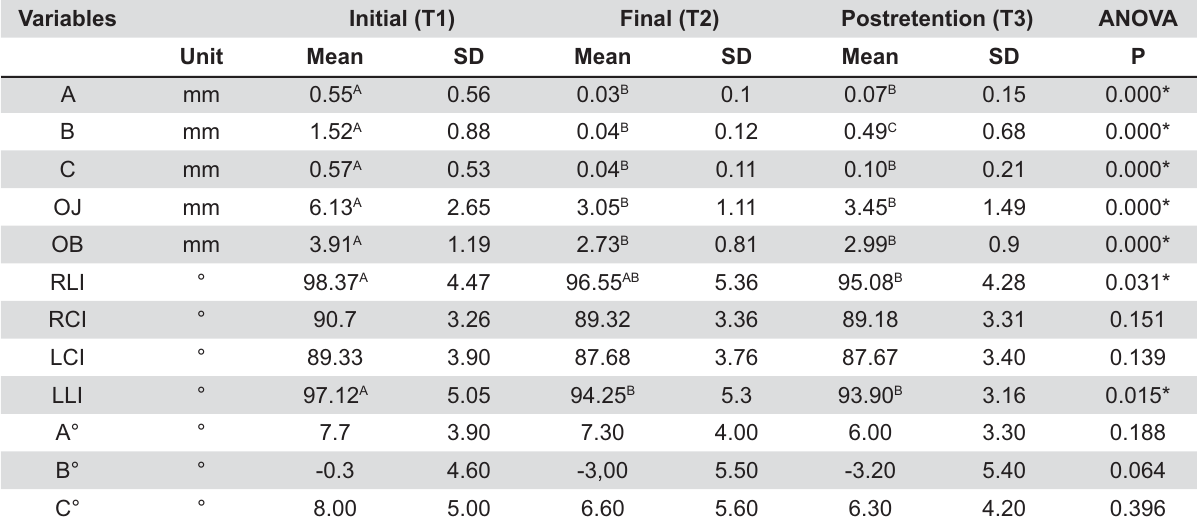
Table 1- Repeated measures ANOVA and Tukey tests to compare the occlusal and radiographic characteristics at the initial (T1), posttreatment (T2) and postretention (T3) stages